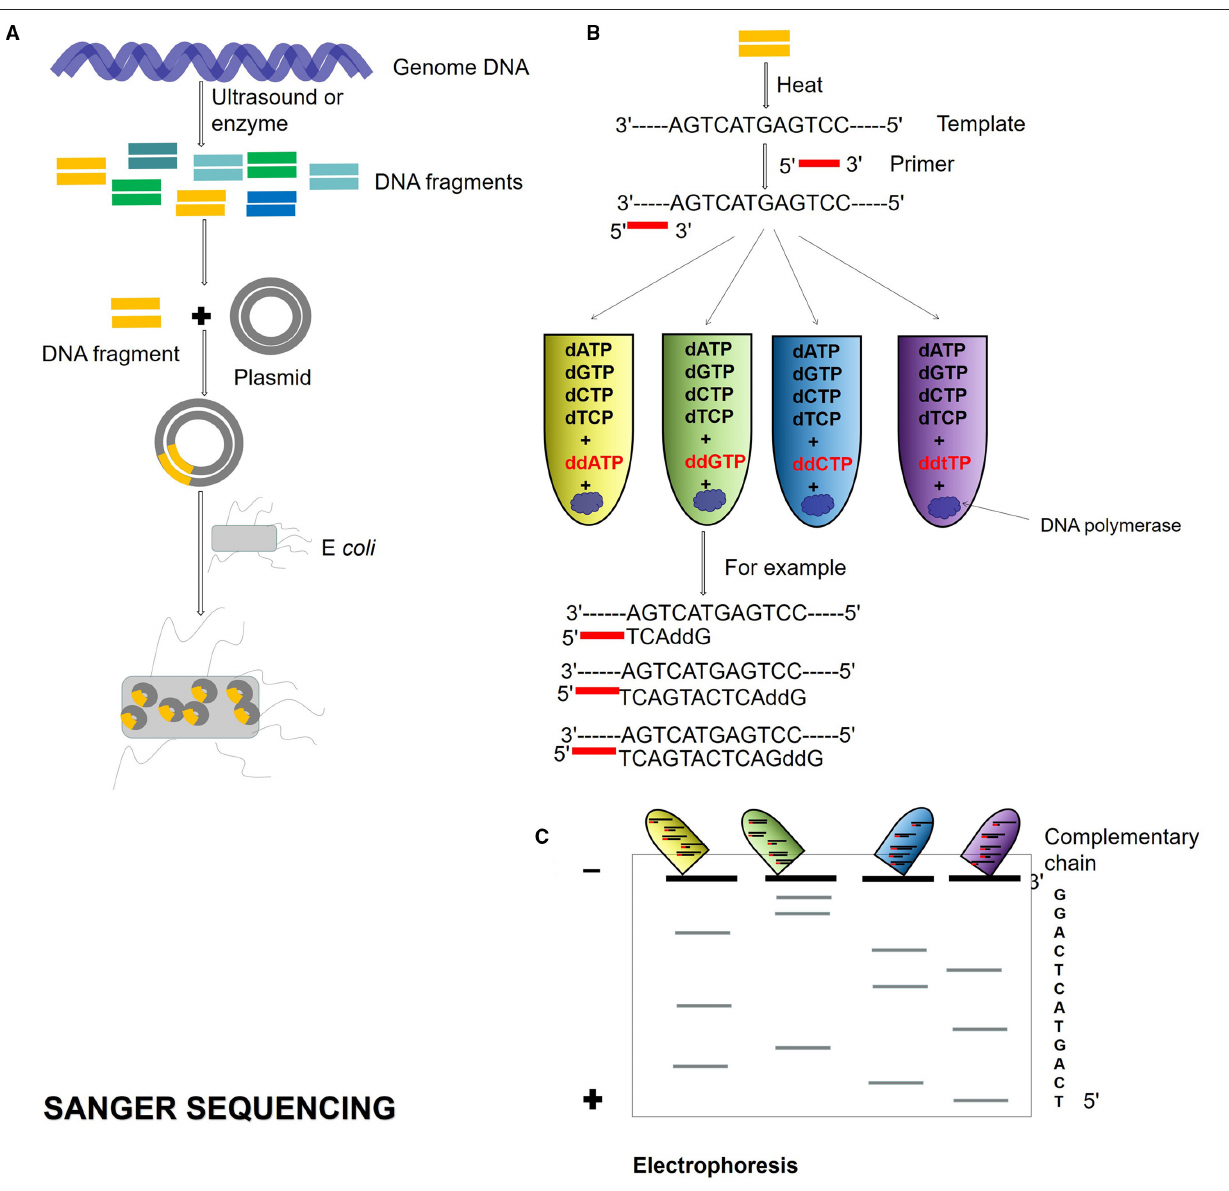
FIGURE 1 | Sanger sequencing process. (A) Genome DNA is cut into different DNA fragments by ultrasound or enzyme, connected into a plasmid, and transformed into Escherichia coli . (B) The Dideoxy chain termination method is used for sequencing. The reaction system is a mixture of template, primer, DNA polymerase, and dNTPs. Four kinds of ddNTP (ddATP, ddTTP, ddCTP, and ddGTP) with radioisotope marks are, respectively, added to four reaction systems. If ddNTP is incorporated into the oligonucleotide chain, the 2 ′ and 3 ′ of ddNTP do not contain hydroxyl groups and cannot form phosphodiester bonds, then the extension of the DNA chain